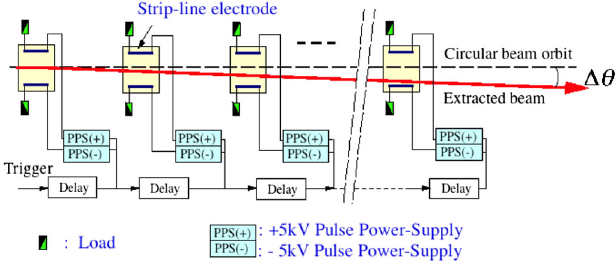
FIG. 1. Schematic layout of the strip-line kicker for the ILC DR: The kicker consists of 15 or more strip-line units. The length of the strip line is limited to realize the rise/fall time and the kick angle of each unit is small. Multiunit is required to realize the specified kick angle.